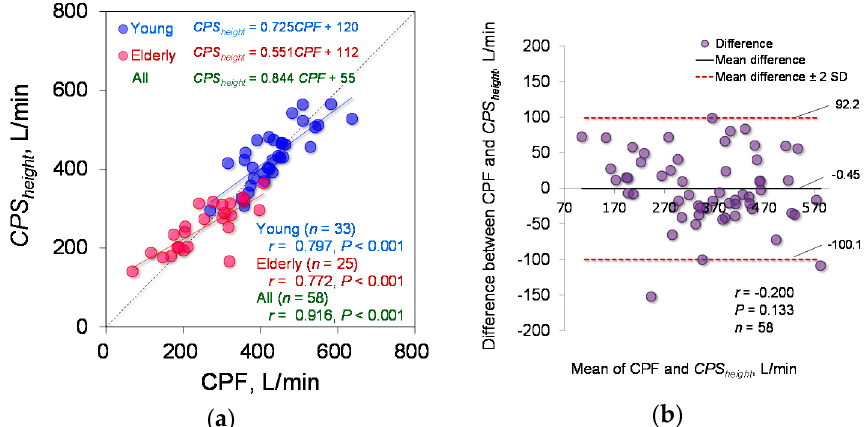
Figure 7. Estimation accuracy of CPS height . ( a ) CPS height against the measured CPF. The linear regression lines are drawn for the young and elderly participant groups, and the corresponding equations are shown in the upper part of each figure, where the green indicates the equation of the regression line for all participants. The right lower part shows the correlation coefficients and p values for each participant group. ( b ) Bland-Altman plot of the measured CPF and CPS height . The horizontal line is the mean of the measured CPF and CPS height . The vertical line represents the difference between the measured CPF and CPS height . The bold black solid lines represent the mean difference between the measured CPF and each CPS height , and the red dotted lines represent the mean difference ± 2 standard deviation bands.